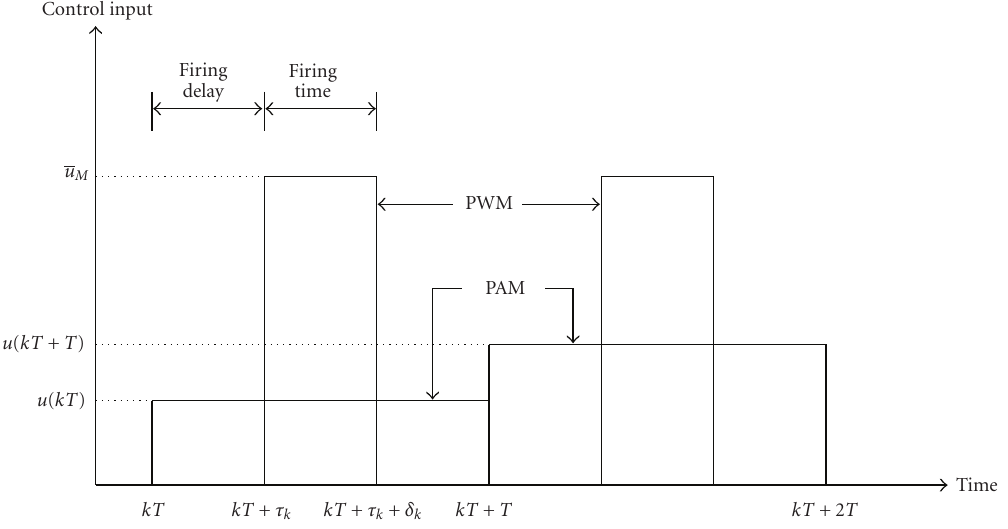
Figure 1: Graphical illustration of PAM and equivalent PWM